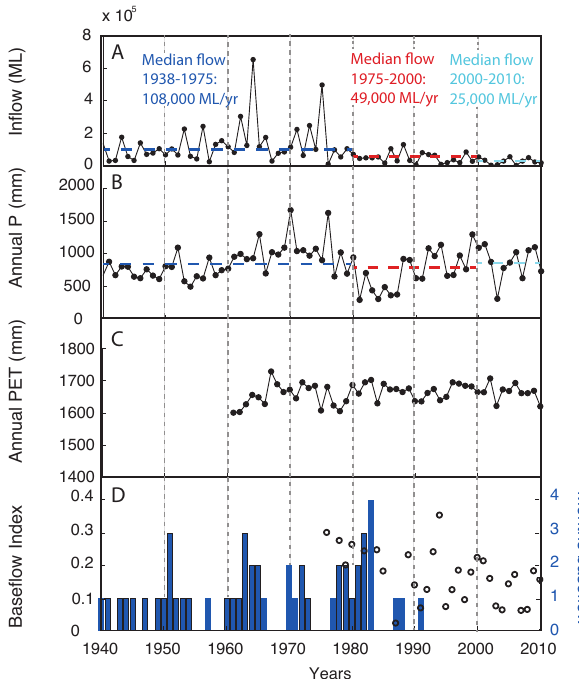
Figure 2. Changes in hydrology and hydrometeorology of the Arka- vathy Basin, 1970–2010. (a) Annual inflows into the TG Halli reser- voir. The 1938–1975, 1975–2000 and 2000–2010 median and mean annual inflows illustrate the decline in inflow that has occurred in re- cent decades. (b) Areally averaged annual rainfall over the seventh taluk (local government areas) comprising the TG Halli catchment. Potential evapotranspiration as estimated from the Hargreaves equa- tion for the TG Halli catchment. (d) Two estimates of baseflow con- tribution to the TG Halli inflows: the number of months/year when 100% of flow was derived from baseflow (bars) and the baseflow index computed from daily inflow data